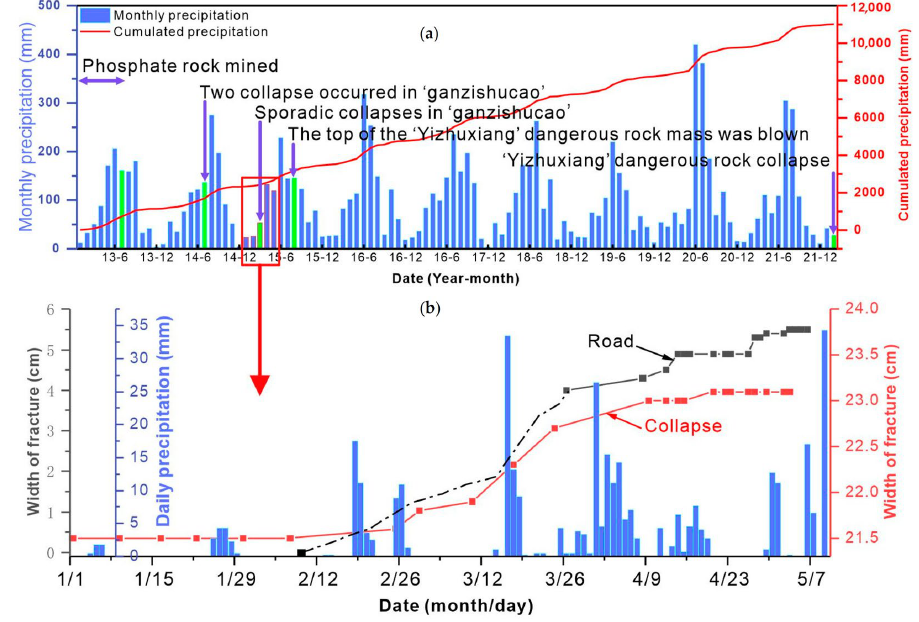
Figure 7. ( a ) Major events during the deformation process of the collapsed body; ( b ) Changes in master fracture [48] and road cracks under